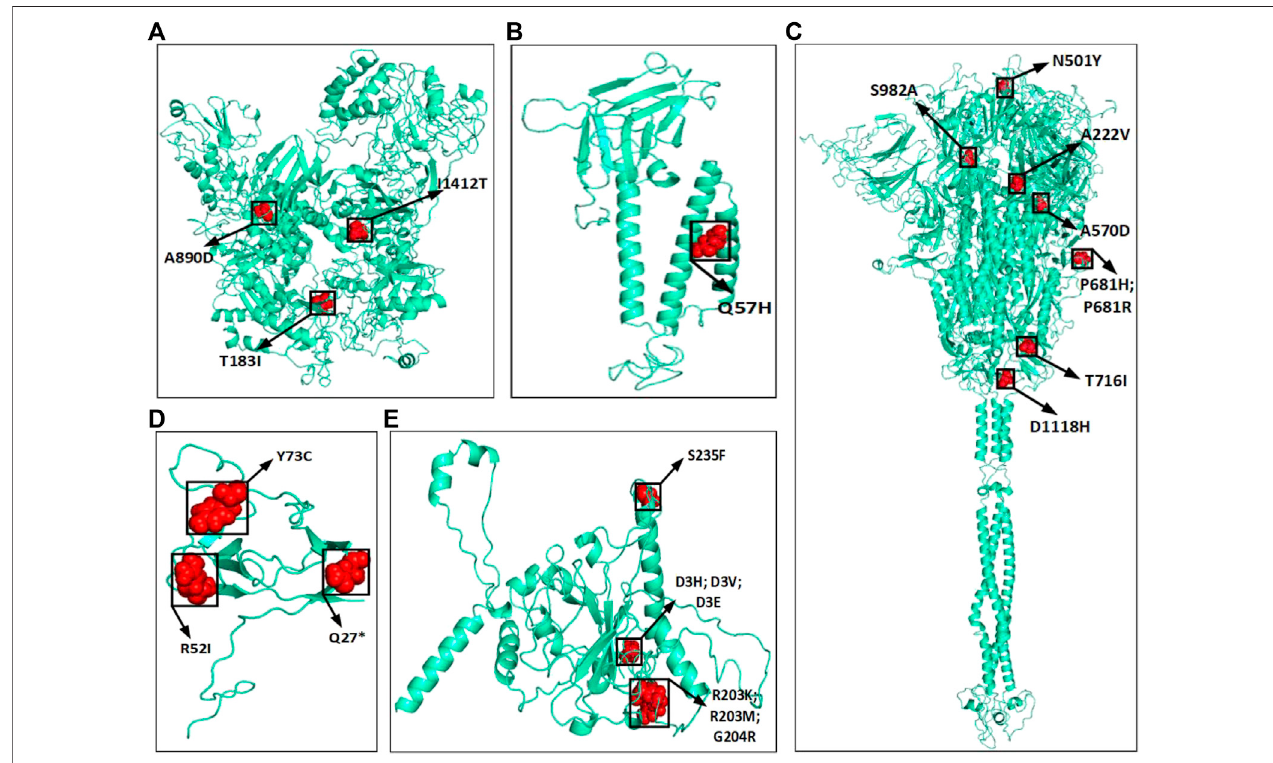
FIGURE3| Highlightedaminoacidchangesintheproteinstructuresforthenon-synonymoussubstitutionsormissensehotspotmutationsforglobalSARS-CoV-2 genomes in (A) NSP3, (B) ORF3a, (C) Spike, (D) ORF8, and (E)